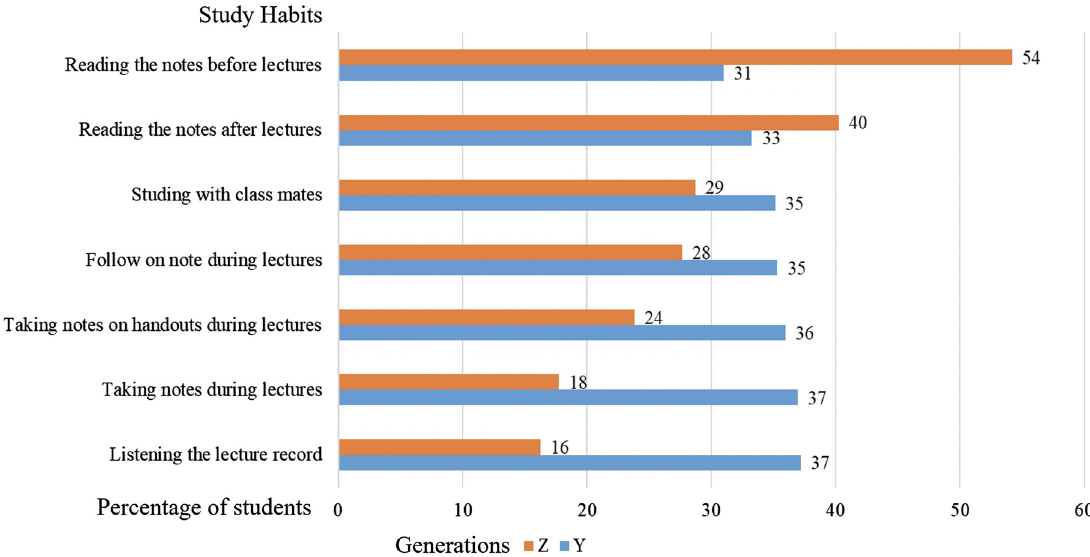
Figure 4: The study habits of students according to generations.